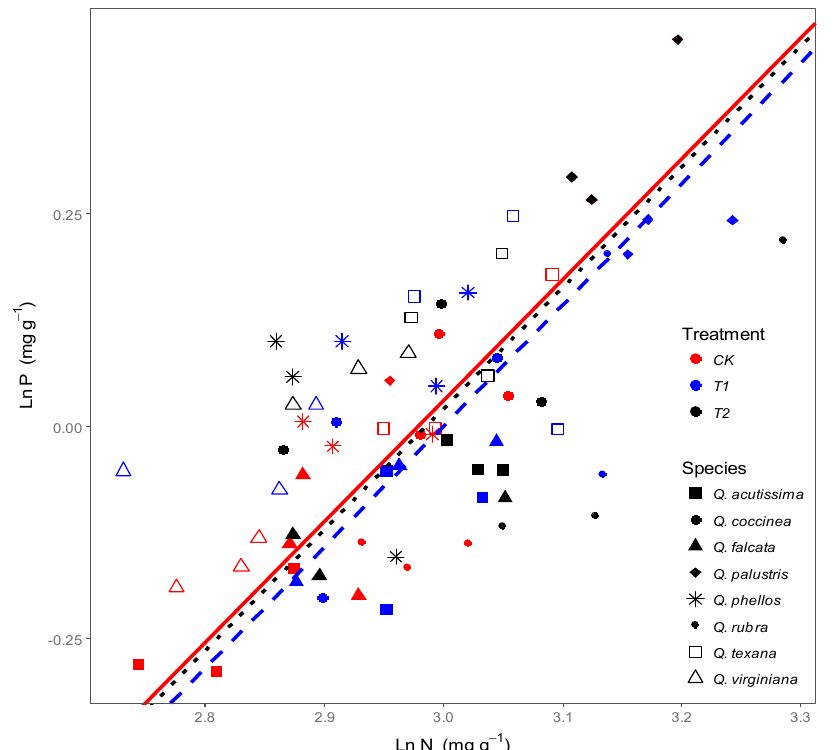
Figure 2. Relationships between leaf N and P concentrations for Quercus species under wind load. Ln N and Ln P: leaf N and P concentrations were transformed using the natural logarithm prior to analysis. CK : control, T1 : about 4 m s − 1 wind speed, T2 : about 6 m s − 1 wind speed. CK : y = 1.02 x − 3.04, R 2 = 0.56, p < 0.01; T1 : y = 0.67 x − 1.98, R 2 = 0.35, p < 0.01; T2 : y = 0.81 x − 2.37, R 2 = 0.217, p = 0.01. SMAs fitted among treatments did not show significant differences in slope (test for SMA (Standardized major axis) heterogeneity, 95% CIS (Confidence intervals), p = 0.26) and in intercept ( p = 0.79).